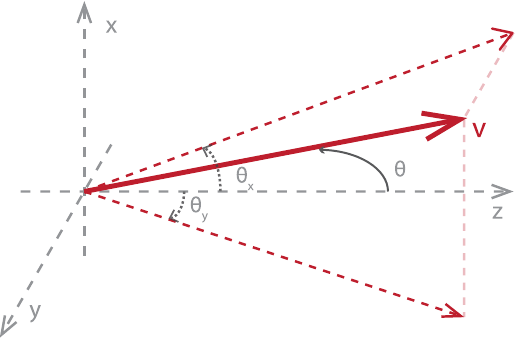
FIG. 1. Schematic of a beam ion at velocity v that has been deflected by a normal angle θ from the axial direction z . The angular deflections θ in the ( x − z ) plane and θ in the ( y − z ) x y plane are